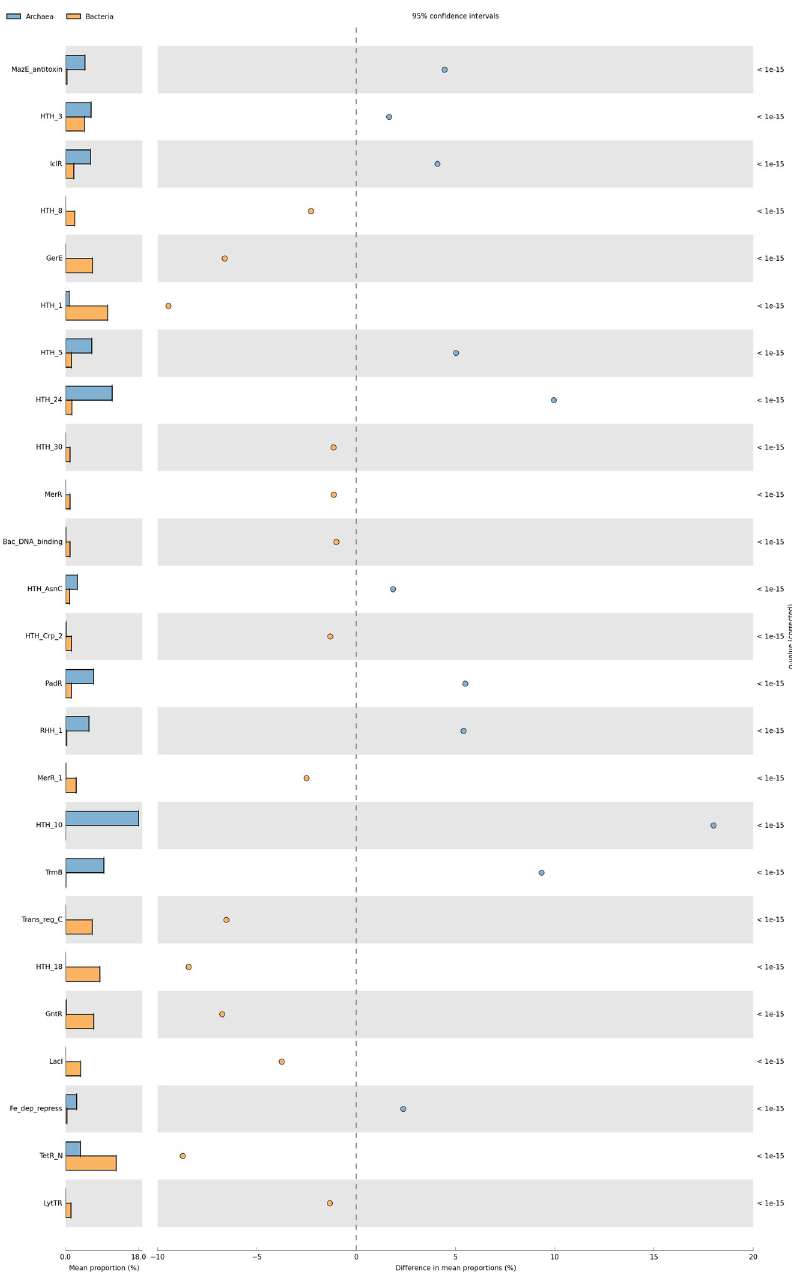
Fig 2. Proportion of families in archaea. The PFAM domains were evaluated to assess the existence of significant differences in their relative proportions. In orange are indicated the archaeal families and in blue the bacterial families. On the x axis is the mean proportion per family (%) and the difference in mean proportions (%). The protein families are in the y